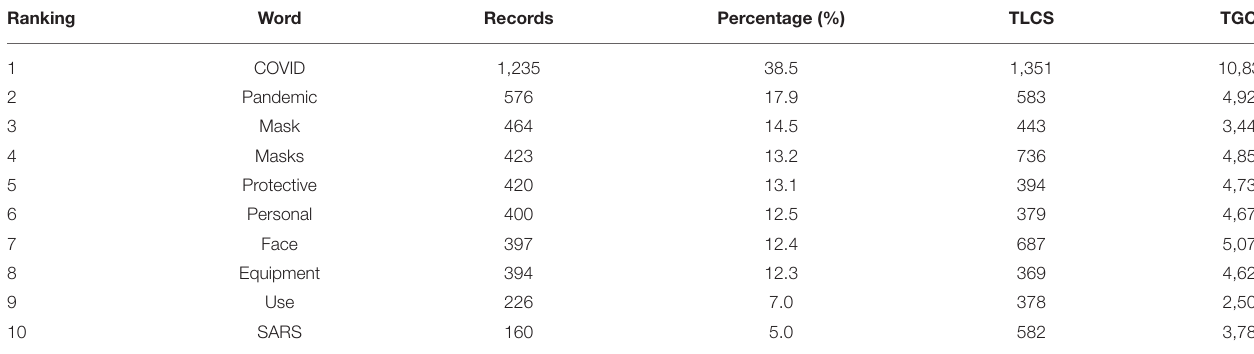
TABLE 5 | Top-10 frequently used words in COVID-19 and PPE.